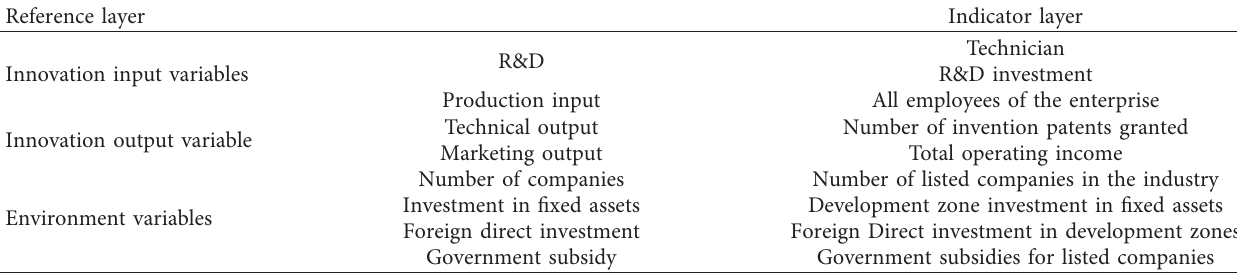
Table 1: Related indicators of innovation efficiency